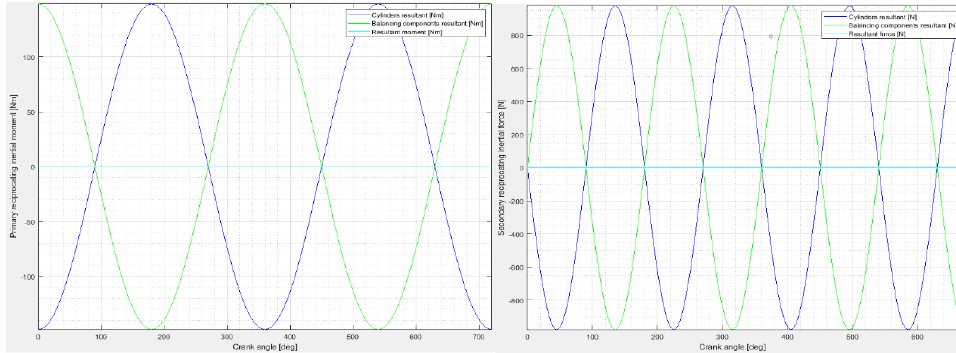
Figure 16. Primary reciprocating moment ( left ) and secondary reciprocating force ( right ) balancing curves for a 4 cylinder